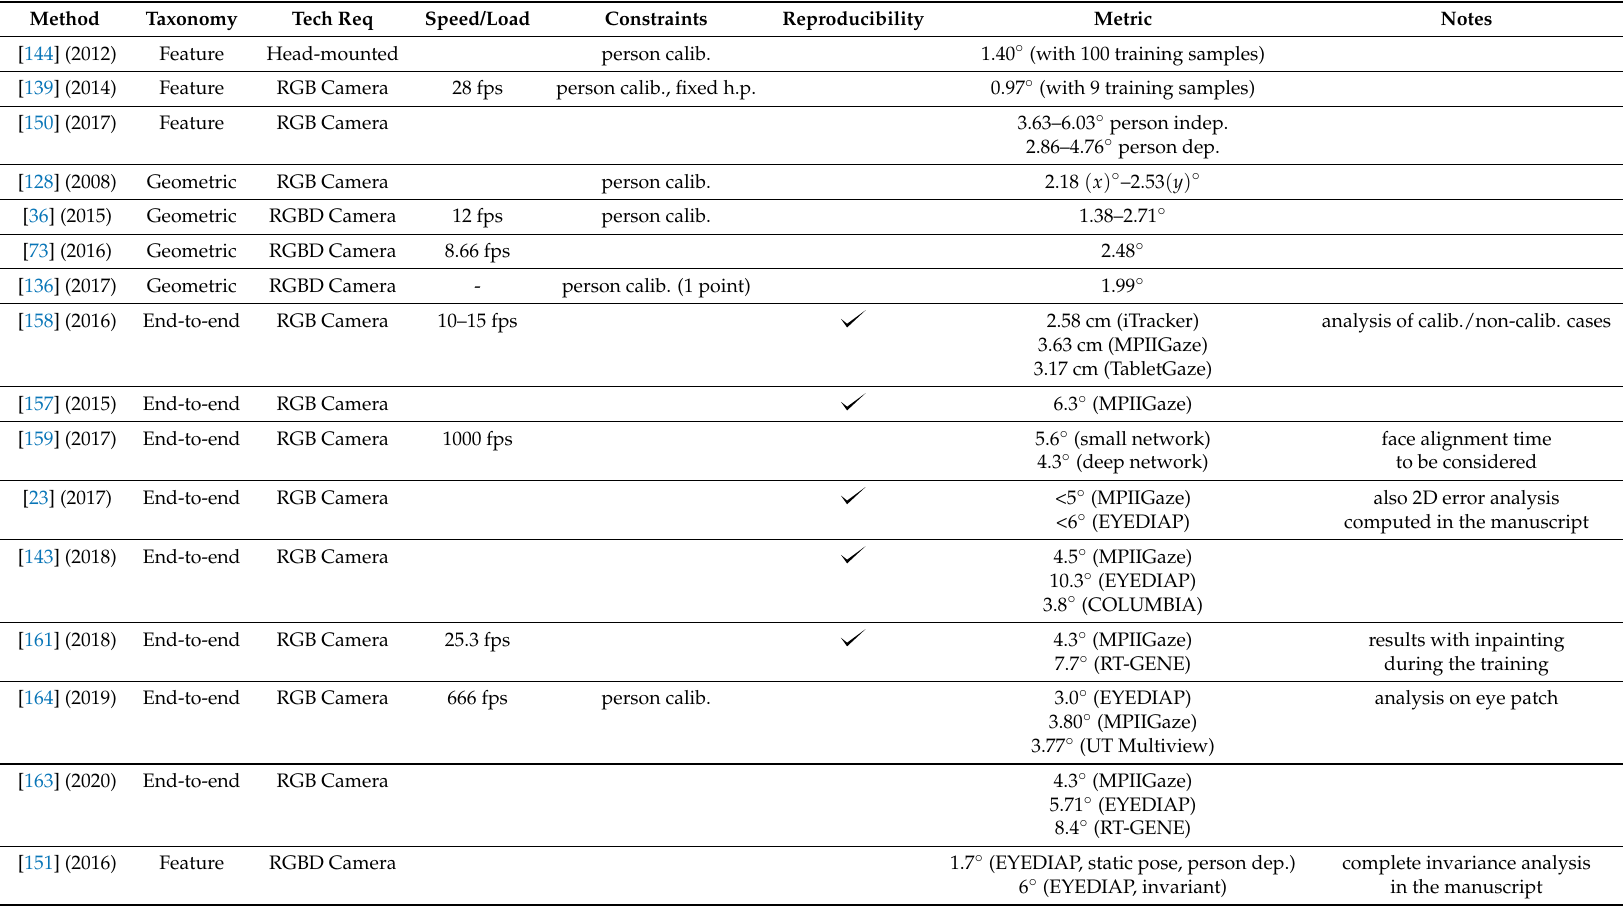
Table 2. A schematic representation of the most important works cited in this document. For each entry, we sum up the taxonomy and eventual technical requirements, as well as other constraints, and performance. The ain datasets whose authors used in the experimental phase are reported. If no dataset is reported, experiments have been done on data not make publicly available or proprietary. The reproducibility of the method in the table means that the code has been made available by the authors and presented results have been gathered on publicly available data; calib. stands for calibration, h.p. for head pose, DL for deep